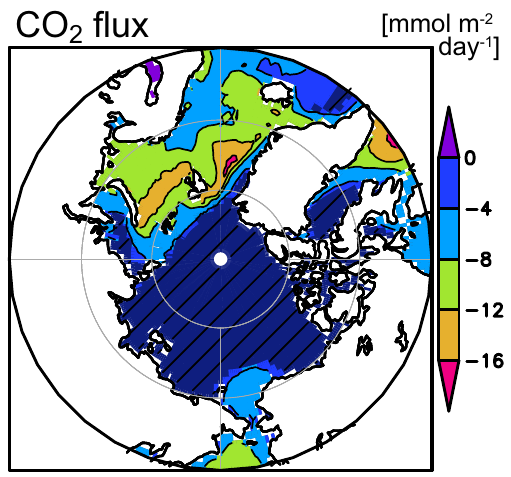
Figure 9. The 18-year annual means of CO 2 flux (mmolm − 2 day − 1 ) (negative values indicate flux into the ocean). Darker hatched areas represent values in grids where fluxes were smaller than the uncertainty, estimated as described in the